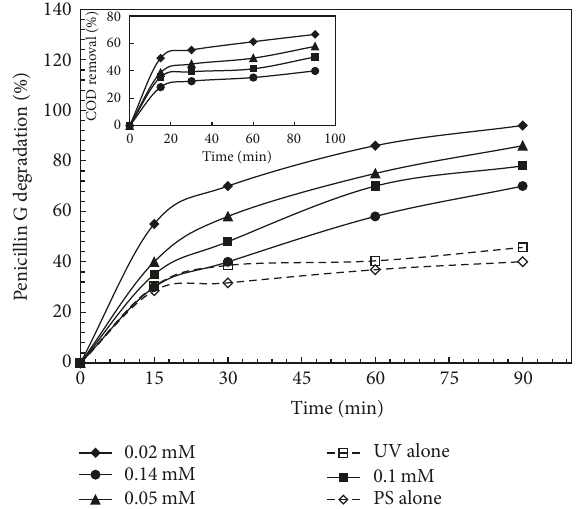
Figure 4: Effect of persulfate concentration on PG and COD degradation by UV-activated persulfate. PG = 0.02 mM, time = 60 min, and pH = 5.